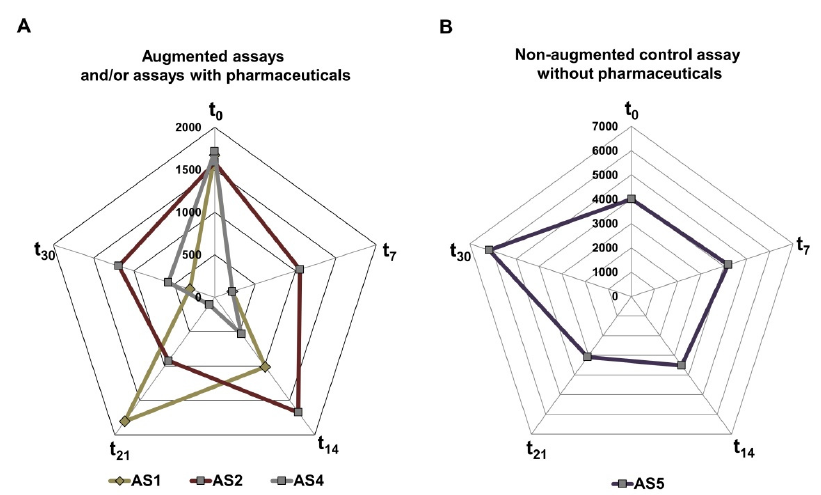
Figure 3. Weekly activated sludge COD (mg L − 1 O 2 ) content on the five AS assays during the experimental period: ( A ) the AS1, AS2, and AS4 are the bioaugmented assays and / or assays with pharmaceuticals; ( B ) the AS5 assay is the control. COD—carbon oxygen demand.